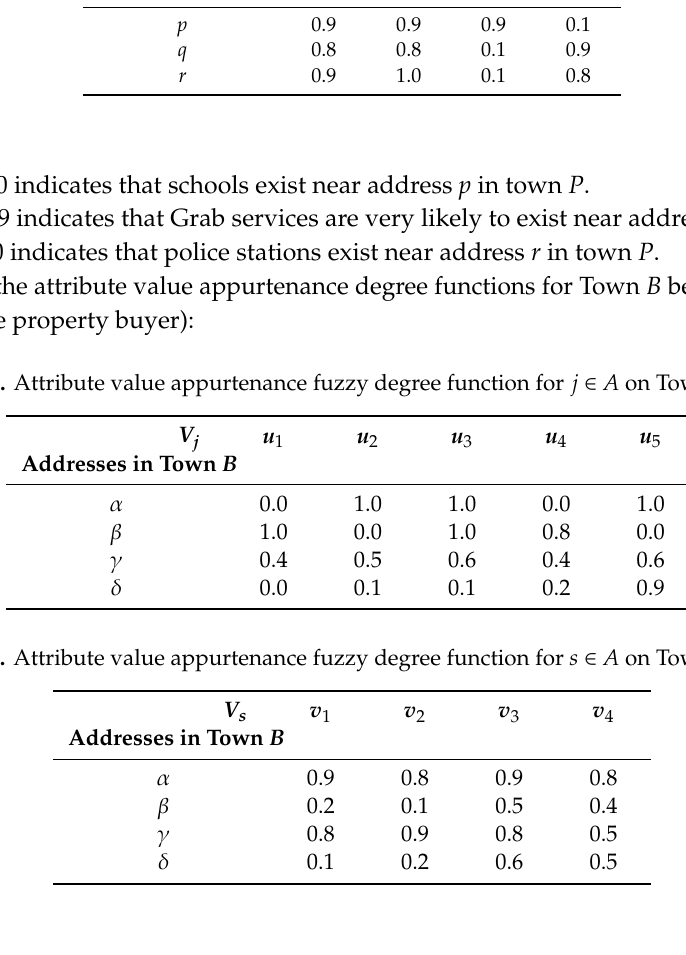
Table 3. Attribute value appurtenance fuzzy degree function for t ∈ A on Town P ( d t ). V t